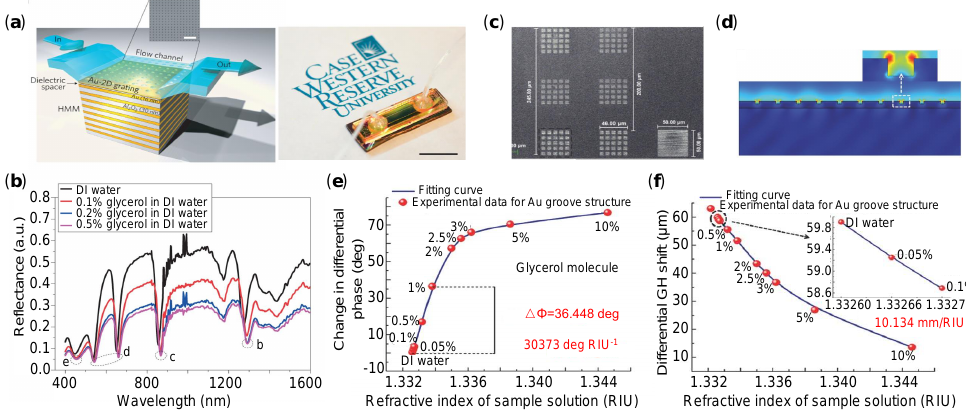
Figure 5. HMM-based plasmonic sensors. ( a ) Schematic of the miniaturized HMM sensing device ( left ). Photograph of the fabricated sensors (right ). ( b ) Measured reflectance spectra of the HMM device obtained by different concentrations of glycerol. ( c ) SEM images of the nanogroove hyperbolic metasurface. ( d ) Resonant electric field distribution on the nanogroove surface. ( e ) Differential phase change of the reflected light related to the concentrations of glycerol solution. ( f ) Differential Goos–Hänchen (GH) shift with respect to the concentration of glycerol solution. Reprinted ( a , b ) with permission from Reference [31]. Reprinted ( c – f ) with permission from Reference